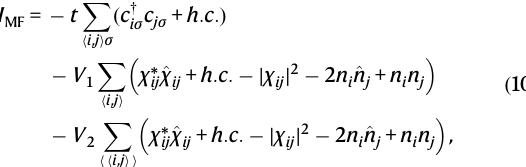
Fig. 4 | Chiral topological PDW and chiral edge modes. a Schematics of a cylindrical kagomé lattice with open boundaries in y -direction. A single 4×4 supercell isshown. Systems studied contain L x × L y supercells. Anin fi nite L x is used along the periodic direction in numerical calculations. b Low-energy quasi- particle spectrum of the triple- Q PDW 1 at Δ p =0.1 t , showing two in-gap CEMs (blue